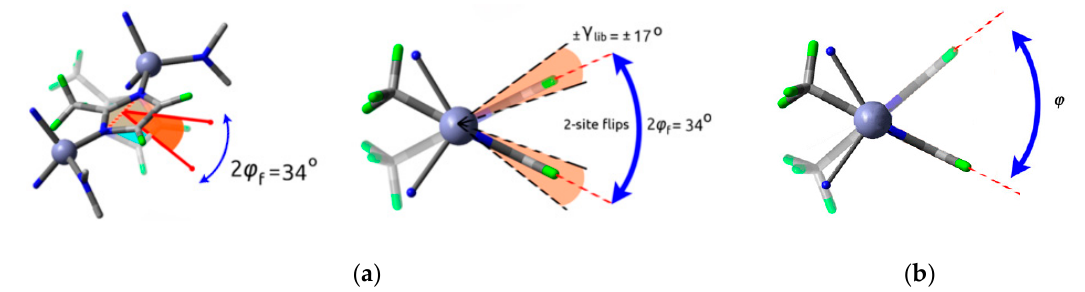
Figure 12. Diverse dynamics of 2-methylimidazolate linker in ZIF-8. ( a ) Small-amplitude two site hopping (34°) and fast librations (± 17°) centered on both hop positions; ( b ) slow, large-amplitude swing. Adapted with permission from [36]. https://pubs.acs.org/doi/10.1021/acs.jpcc.5b09312; further permissions should be directed to the ACS. Copyright American Chemical Society, 2015.